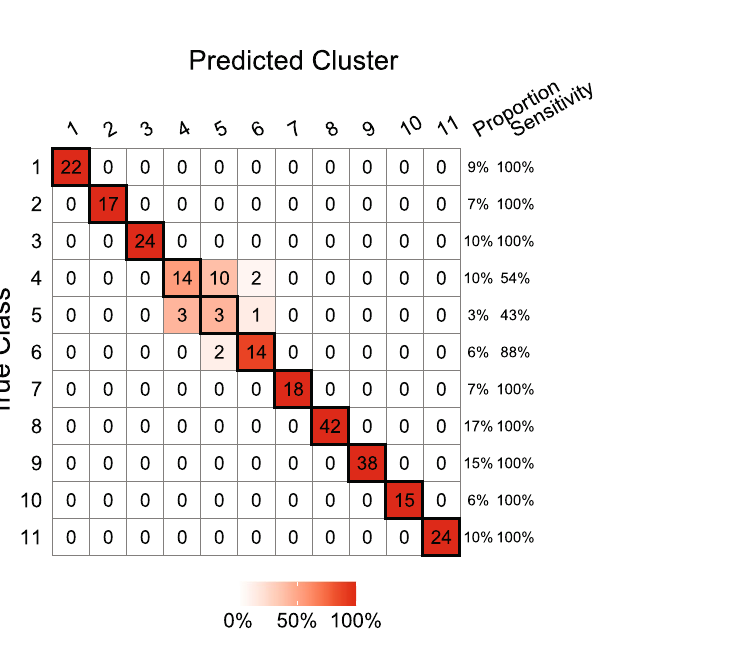
G ( V k 2 ) , where the clusters are rearranged with the